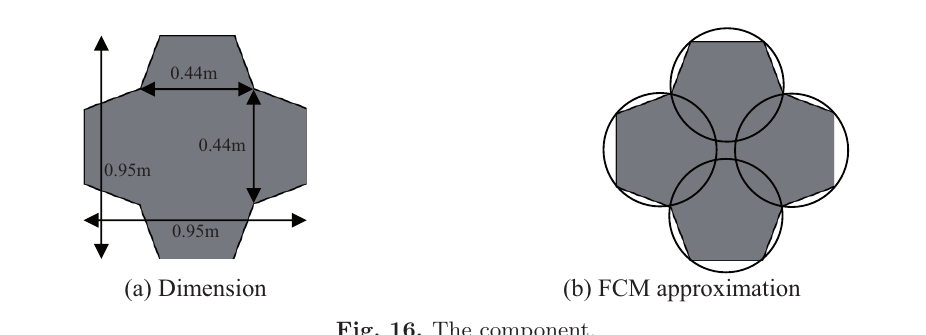
Fig. 15. The design domain.